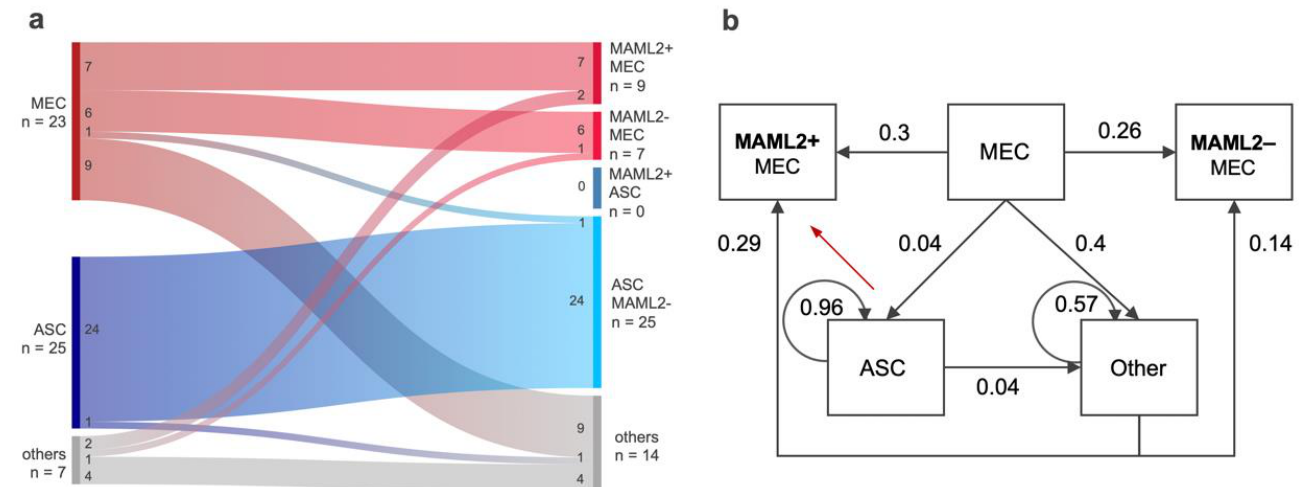
Figure 3. State transition probability. ( a ) Alluvial diagram to represent changes from working diagnosis before molecular testing to final diagnosis. The states MEC, MAML2+, MAML2 − , ASC, and others were assigned as variables to parallel vertical axes. The values represent the total number of cases in each group before and after molecular diagnoses. The height of each block represents the size of the cluster, and the height of each stream field represents the size of the components contained in both blocks connected by the stream field. ( b ) Pre- and post-molecular fusion analysis diagnoses represent states in a memoryless (Markov) stochastic process where state transitions (arrows) are determined exclusively by the relationship between the pre-molecular diagnoses and the post-molecular fusion analysis diagnoses. The empirical estimates of state transition probabilities were computed by simply conditioning and normalizing the data. Given the size of our data set, relative to that of the state space, these empirical estimates were not expected to converge to the true values of the underlying state transition probabilities, but rather represent our observations via pure summary statistics. Numbers indicate the probability of transitions from the indicated states to another, with the 3 states of working diagnosis MEC, ASC, and others and 4 states at final diagnosis ( MAML2+ MEC, MAML2− MEC, ASC, and other ). The transition from ASC to MAML2+ MEC did not exist and is therefore marked with a red arrow. Abbreviations: ASC, adenosquamous carcinoma; MEC, mucoepidermoid carcinoma.